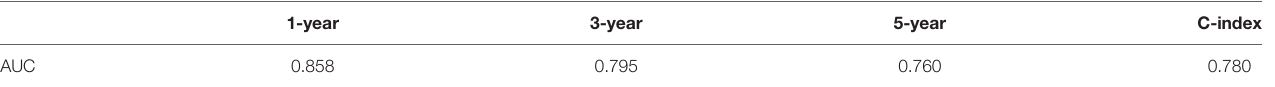
TABLE 2 | The 1-, 3-, 5-year AUCs and C-index of our constructed